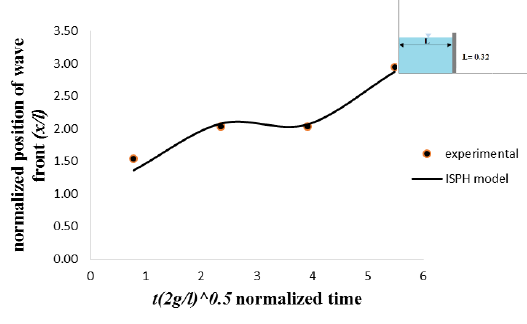
Figure 5 Comparison of numerical and experimental normalized graph of the location of the wave front for the dam-break wave flow against a rigid obstacle test case. TABLE 1. Evaluation of the ISPH numerical model via relative error statistic for the dam-break flood wave against an isolated obstacle test case. Relative error of Relative error Time(s) wave height %